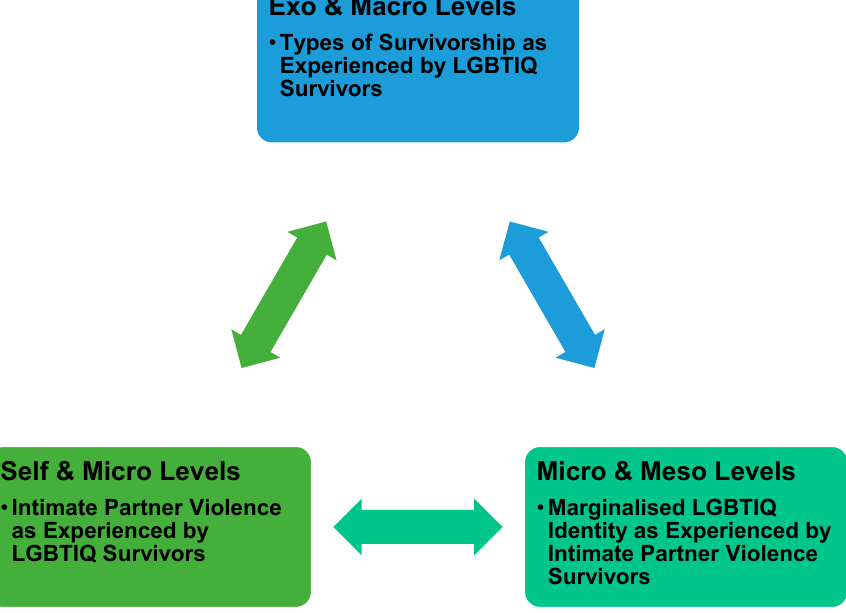
Figure 3. The interconnected nature of LGBTIQ IPV and Socioecological Theory.